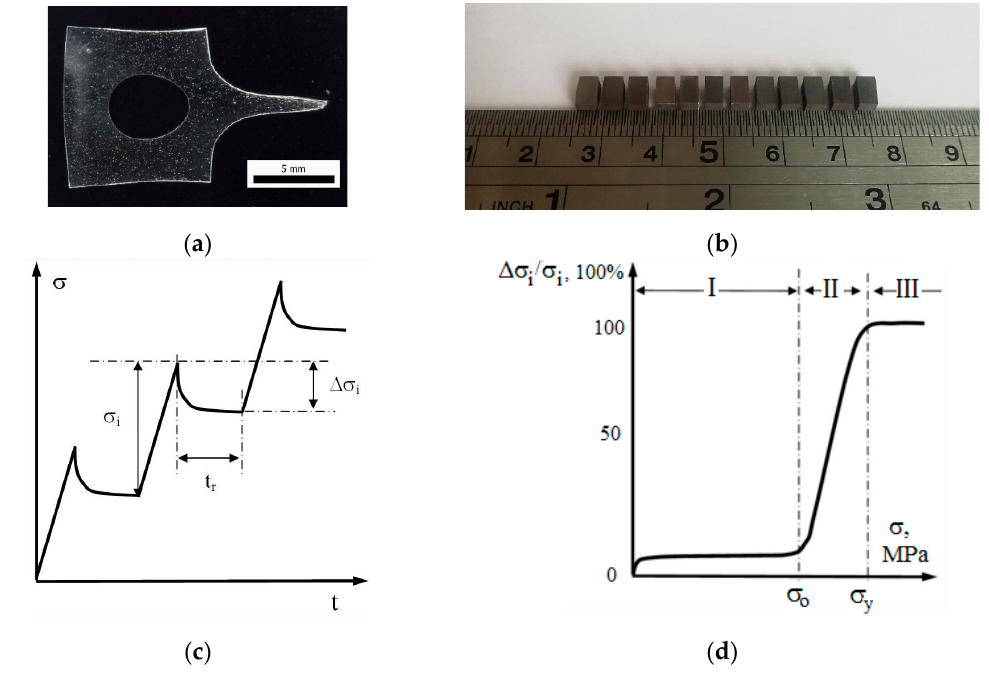
Figure 2. Specimens ( a , b ) and test procedures ( c , d ). General view of specimens prepared for ten- sion ( а ) and stress-relaxation ( b ) tests. Stress-relaxation test technique: ( c ) typical load and σ i (t) relaxation curves, ( d ) ∆σ i ( σ ) typical curve.